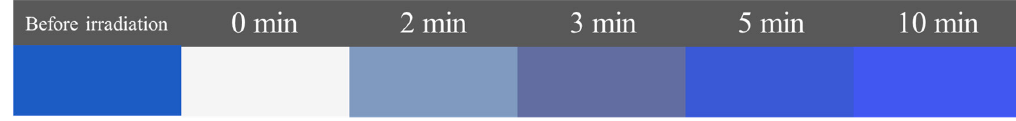
Figure 8. The color change in the oxygen indicator during recovery (in air).